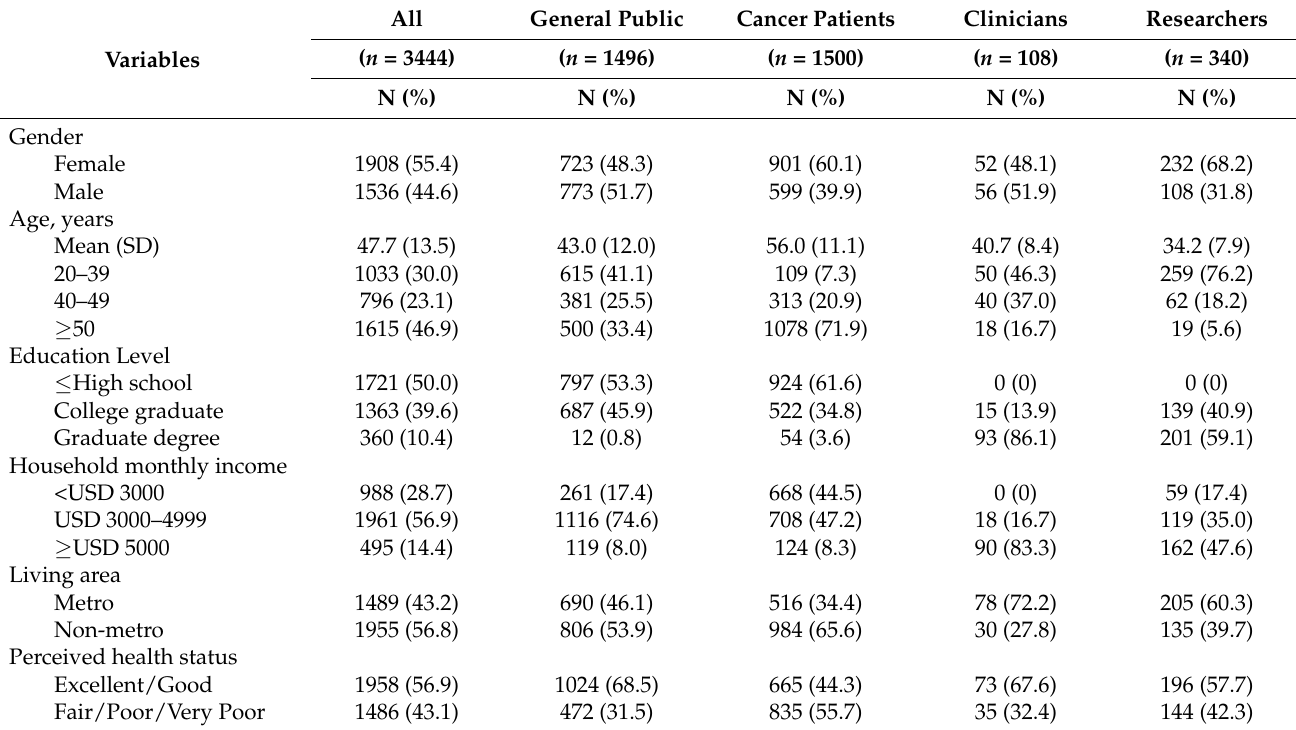
Table 1. Sociodemographic characteristics by respondent